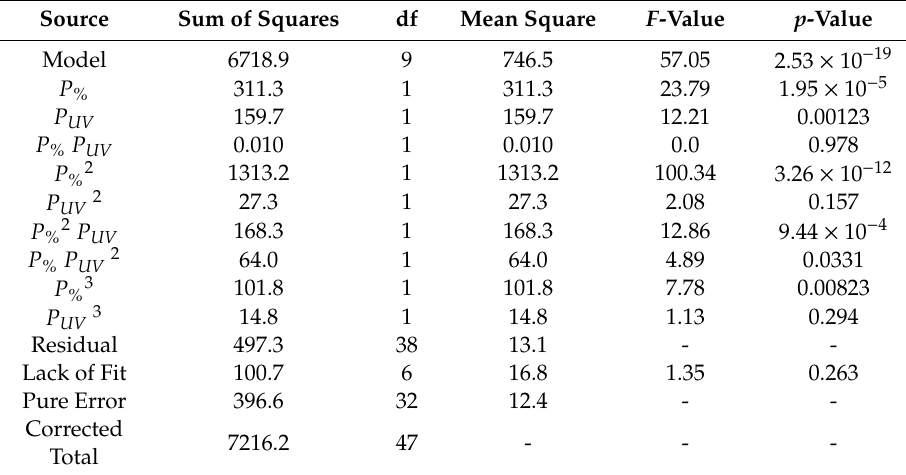
Table 10. ANOVA results for the τ u parameter in the complete cubic model for unbending.